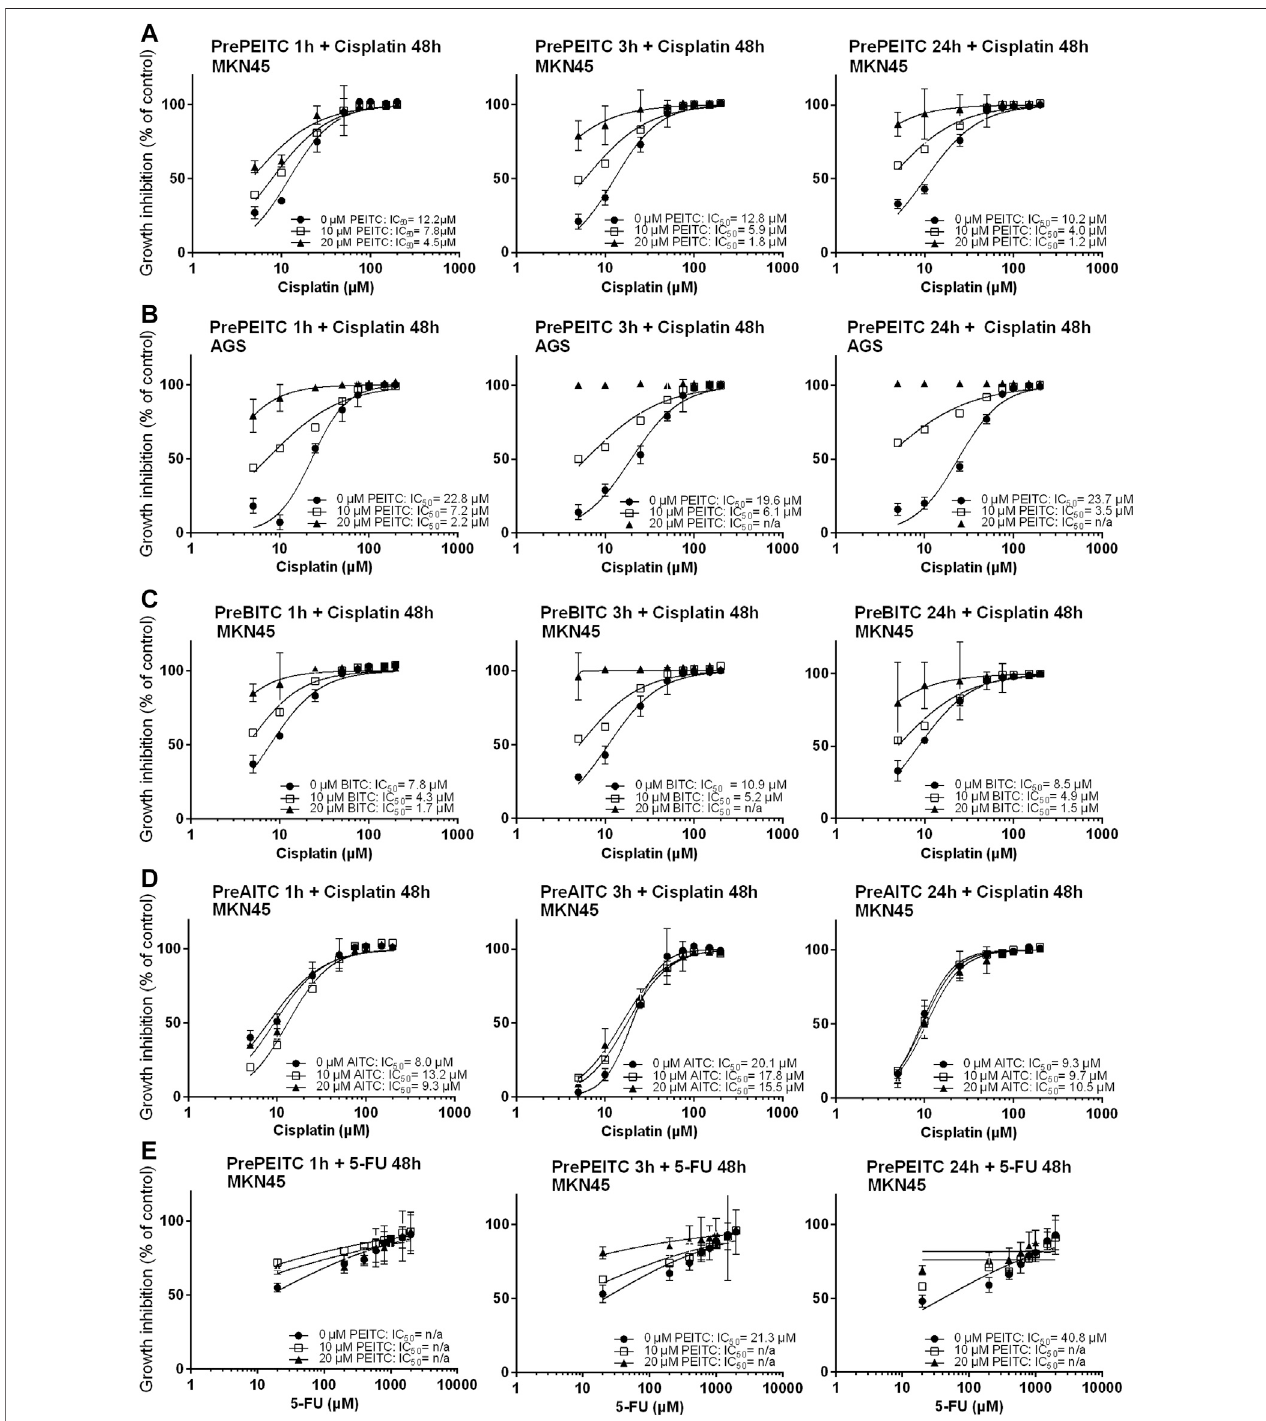
FIGURE 5 | Inhibition of proliferation (relative to vehicle control, 3% PBS) in cell cultures of MKN45 pre-treated with 10 and 20 µM PEITC for 1, 3 and 24 h before treatedwith5 – 200 µMCisplatinfor48 h (A – E) .( B,C) sameas (A) butwithpre-treatmentwithBITCorAITCinsteadofPEITC,respectively. (D) sameasin (A) usingAGS cells instead ofMKN45. (E) same asin (A) but treating cells with 5- fl uorouracilfor 48 h instead ofcisplatin following pre-treatment with PEITC. Values represent mean of n (cid:1) 3 – 6 replicates. SD values were omitted from cultures with 98% or higher inhibited growth as these yielded non-representatively high SD values. PEITC: phenethyl isothiocyanate; BITC, benzyl isothiocyanate; AITC, allyl isothiocyanate.